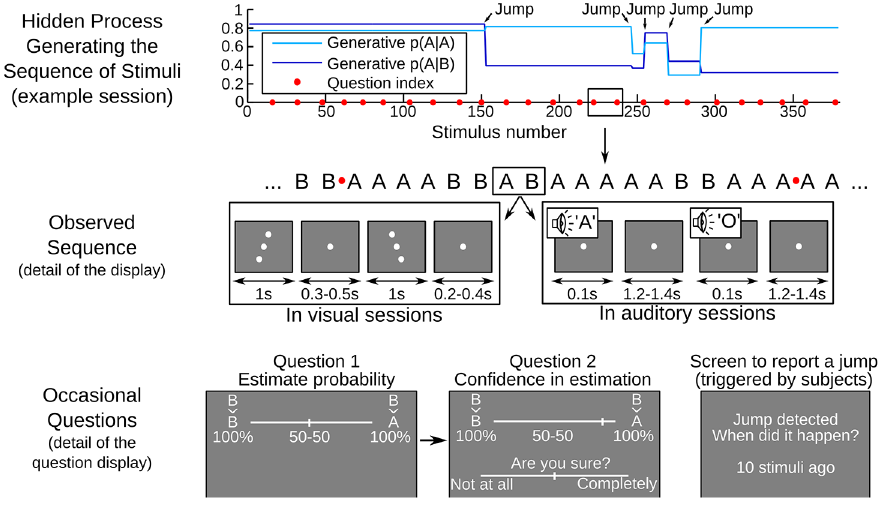
Fig 1. Behavioral task for the joint assessment of probability estimates and confidence. Subjects were presented with series of auditory or visual stimuli (denoted A and B) and were occasionally interrupted by questions asking for their estimate of transition probability (e.g. B ! A) and their confidence in this judgment. The top graph illustrates the characteristics of the hidden process generating the sequence of stimuli in an example session: transition probabilities changed 5 times at random 'Jump' points, delimiting 6 chunks of variable length. The middle section shows a portion of the generated sequence. The actual stimuli are illustrated by gray screen-shots: in different sessions, stimuli were either visual (a line of dots tilted clockwise or anti-clockwise) or auditory (vowels 'A' or 'O' played through a loudspeaker). The sequence of stimuli was interrupted every 15 ± 3 stimuli (see red dots). At this moment, the previous stimulus (here B) was displayed and subjects indicated with a slider their estimate of the probability for the next stimulus to be A or B. In the actual display, A and B were replaced by the corresponding visual symbols or vowels. Once subjects had validated their probability estimate, they were asked to rate with a slider how confident they were in their probability estimate. Subjects also had to report on-line when they detected jumps: they could stop the sequence at any time by pressing a key to indicate how long ago the jump had supposedly occurred (see the bottom right-hand screen shot). After such reports, the stimulus sequence was resumed without